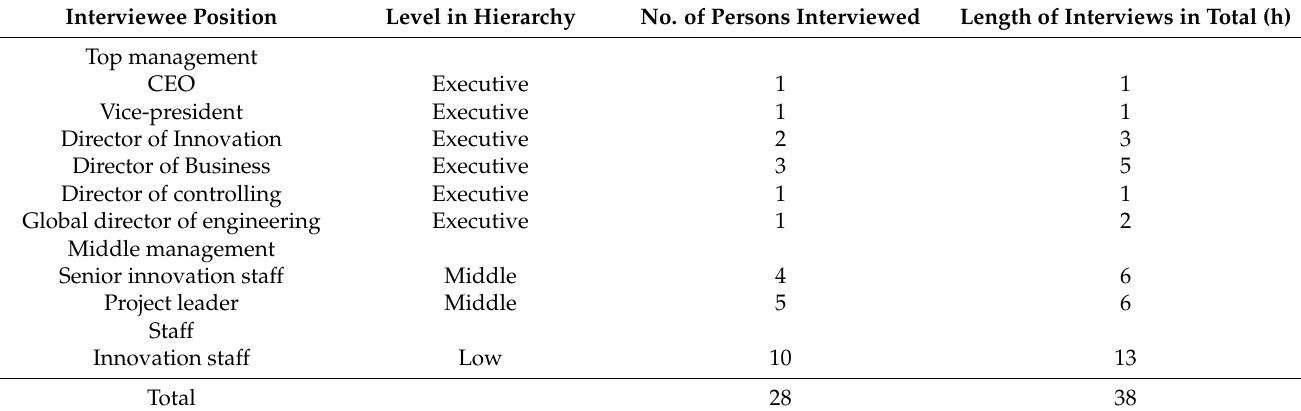
Table 1. Details of the case